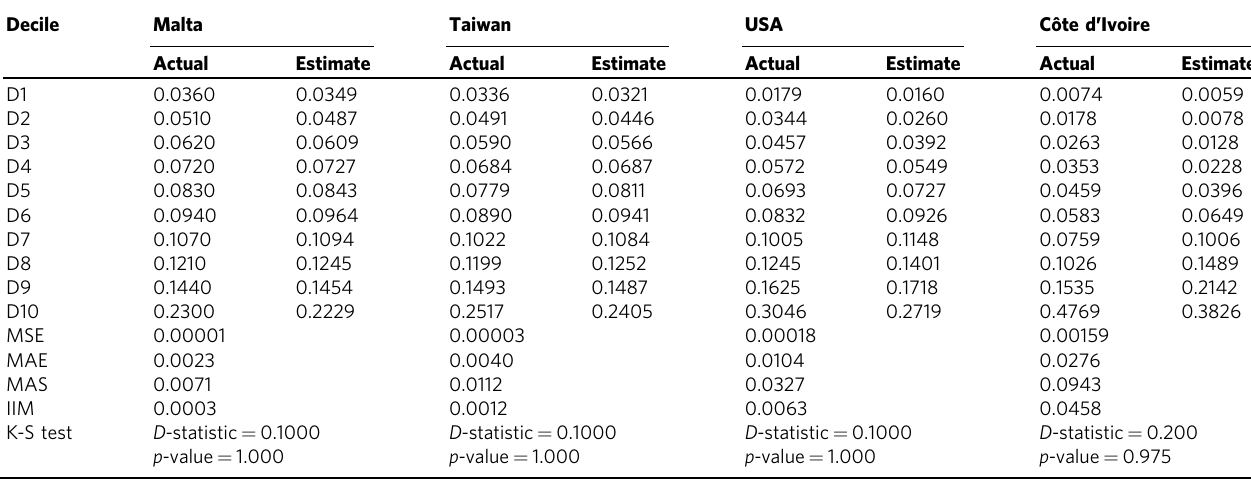
Table 2 The comparison between the actual and the estimated income shares by decile calculated using the simple method that utilizes the data on the Gini index and the income shares of the bottom 10% and the top 10%.